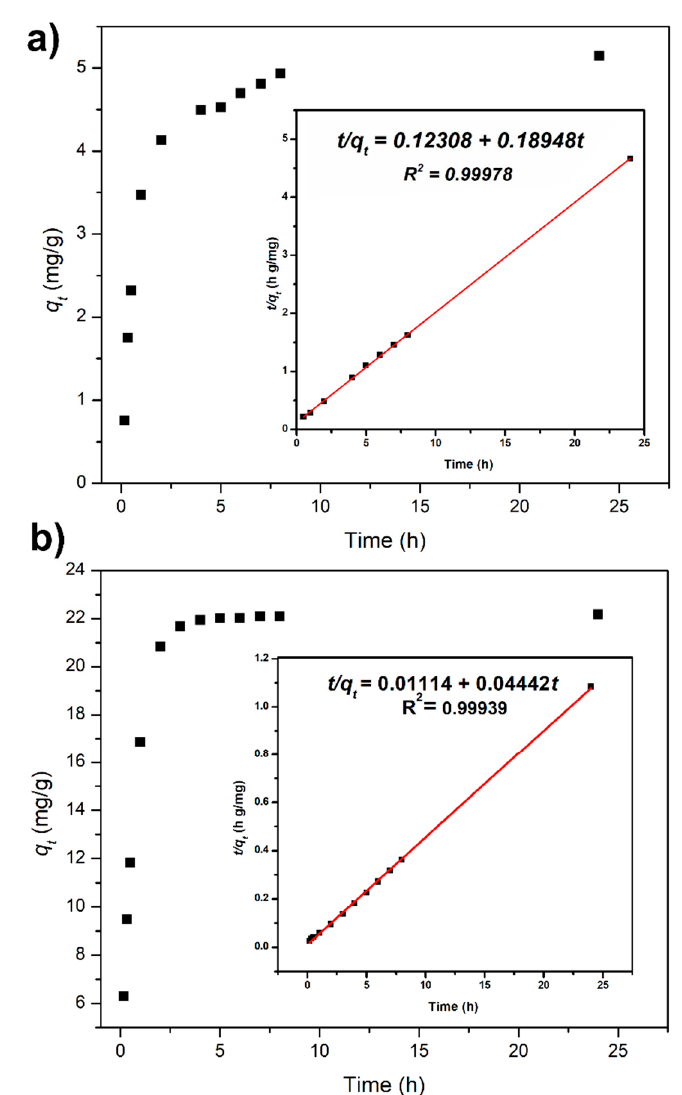
Figure 8. Adsorption kinetics of ( a ) cellulose without treatment and ( b ) cellulose treated with succinic anhydride (Com-1). Inserts show the experimental data fitted to a pseudo-second-order kinetic model . Table 2. Constants and correlation coefficients for the kinetic models.